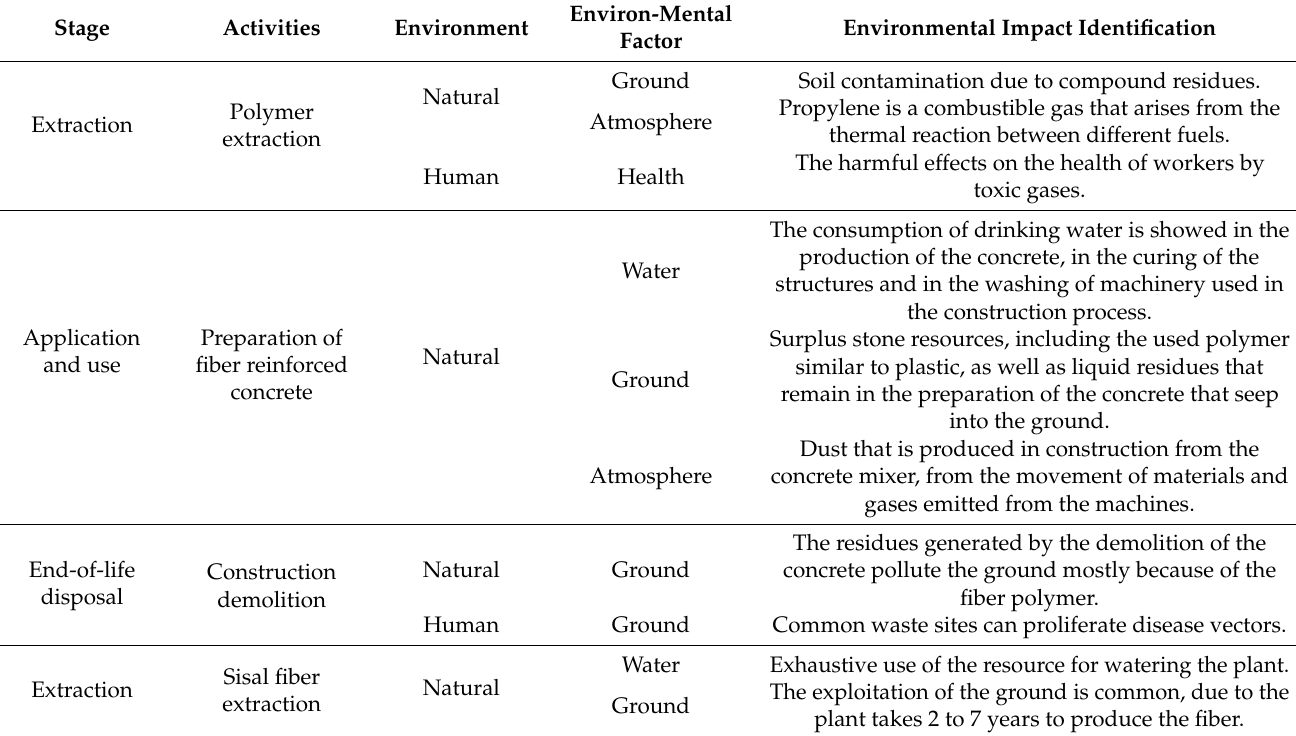
Table 6. Environmental factor and